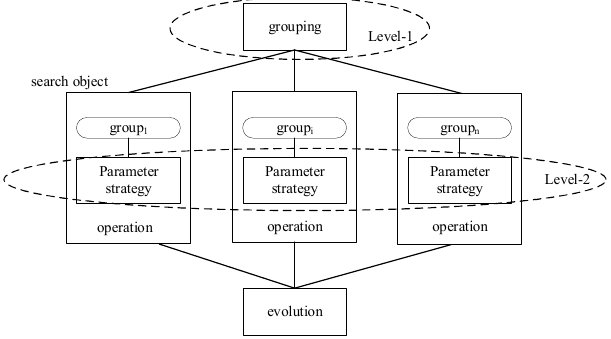
Figure 4. Grouping based two-level parameter combination scheme.